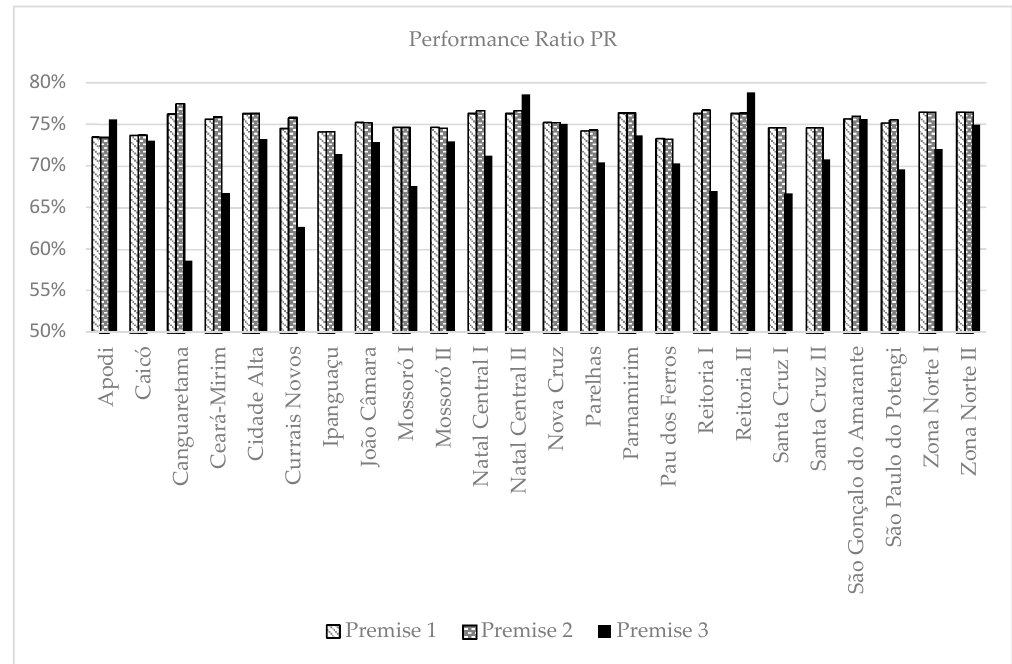
Figure 4. Performance Ratio, PR, for the IFRN-Solar project plants considering Premises 1, 2, and 3.